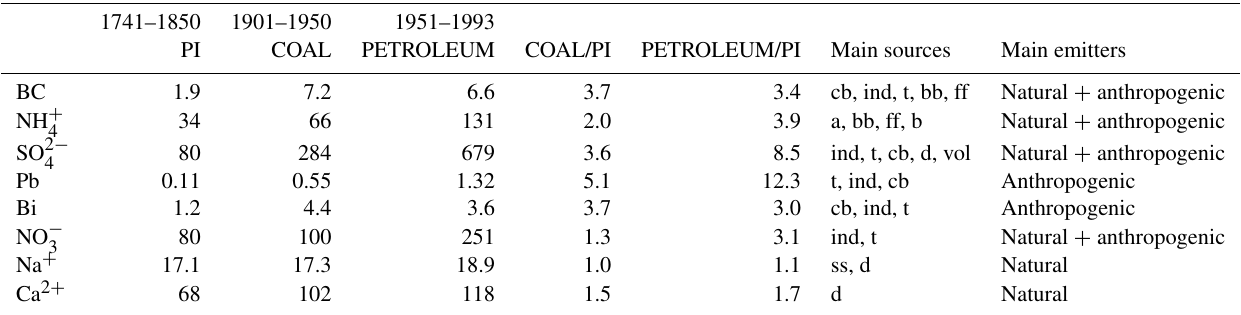
PI COAL PETROLEUM COAL/PI PETROLEUM/PI Main sources Main emitters